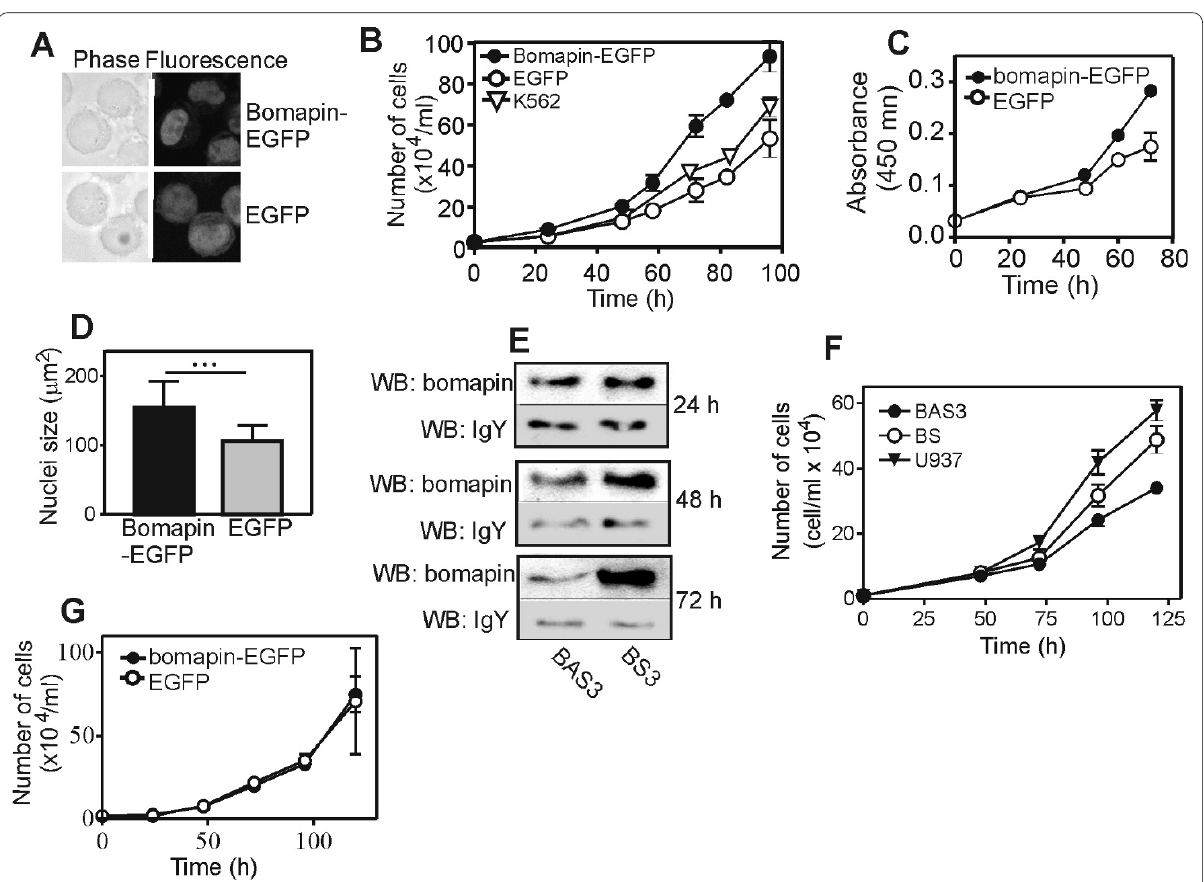
Figure 2 Wt bomapin promotes proliferation of stably-transfected multi-clonal K562 cells . (A) Cellular localization of bomapin-EGFP and EGFP in transfected K562 cells. (B) Proliferation of the K562 cells expressing bomapin-EGFP and EGFP, and the wt K562 cells (seeded at 2 × 10 4 cell/ml) mea- sured by manual cell counting. The data represent a mean of three independent experiments, each counted in triplicate. (C) Proliferation of the stably transfected K562 cells measured with the WST-1 reagent. (D) Size of nuclei in K562 cells expressing bomapin-EGFP and EGFP. The symbol "..." indicates statistical significance with p < 0.0001 by unpaired t-test. (E) U937 cells were incubated with bomapin-specific antisense (BAS3) and sense (BS) phos- phorothioated DNA oligonucleotides (20 nmol/ml); at different time points bomapin was immunoprecipitated with IgY immobilized on NHS-Sephar- ose and detected with western blot. Western blot of residual amounts of IgY detached from the beads during immunoprecipitation is shown as loading control. (F) U937 cells were seeded at a density of 1 × 10 4 cells/ml in the absence or the presence of the antisense BAS3 and corresponding sense BS oligonucleotides, and proliferation was measured by manual counting. The data represent the means of three independent experiments, each counted in triplicate. (G) Proliferation of the HT-1080 cells expressing bomapin-EGFP and EGFP (seeded at 2 × 10 4 cell/ml) measured by manual cell counting. The data represent a mean of three independent